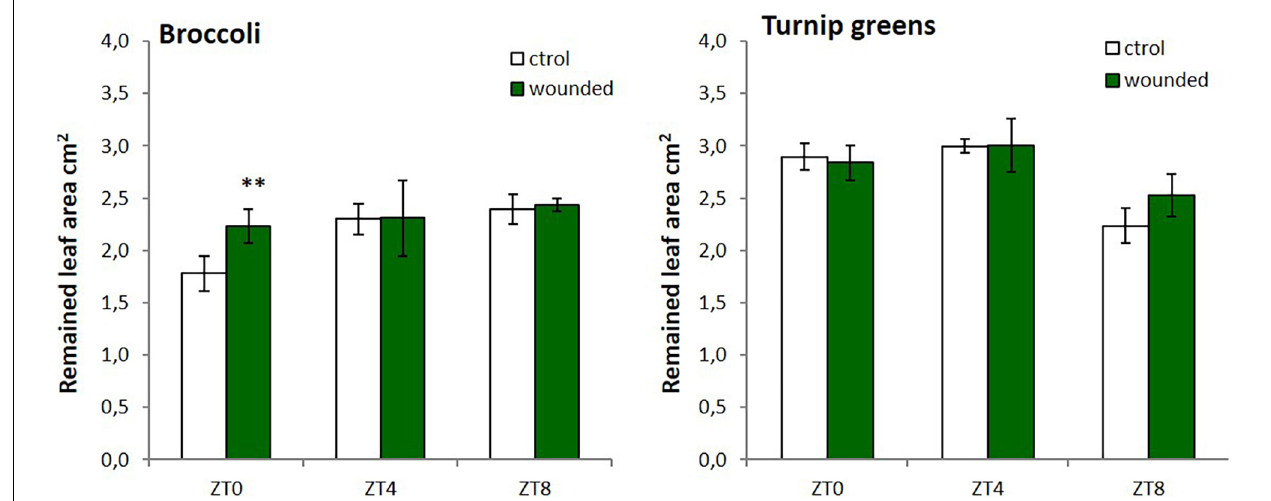
FIGURE 3 | Average area of leaves disk remaining after 24 h of Mamestra brassicae L. feeding. Error bars represent ± standard error (SE). Leaves were collected from plants wounded at dawn (ZT0), mid-day (ZT4), or dusk (ZT8) during three consecutive days. The asterisk indicates statistically significant differences between mean values according to Student’s t -test ( ∗∗ p < 0.001).